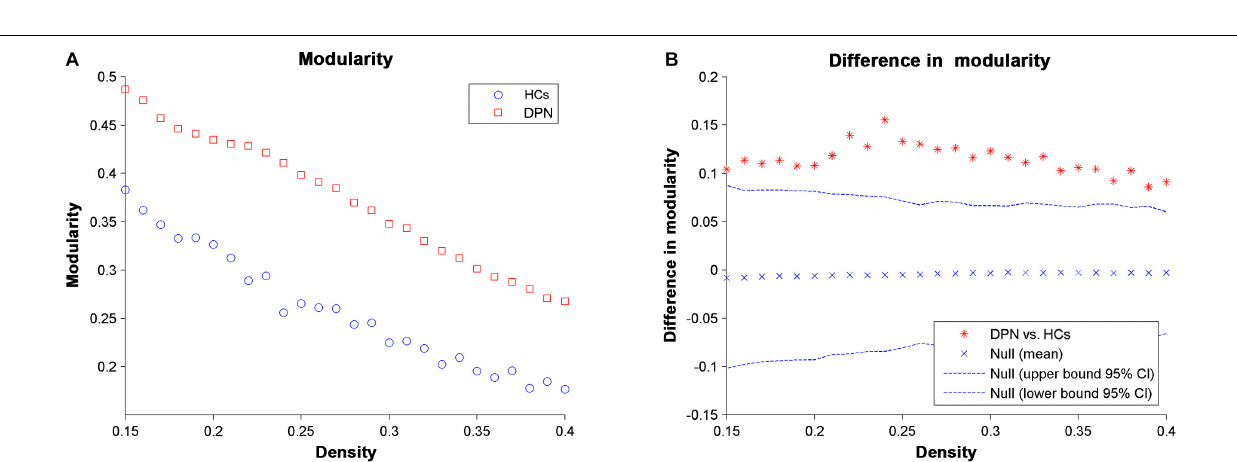
Frontiers in Neuroscience | www.frontiersin.org